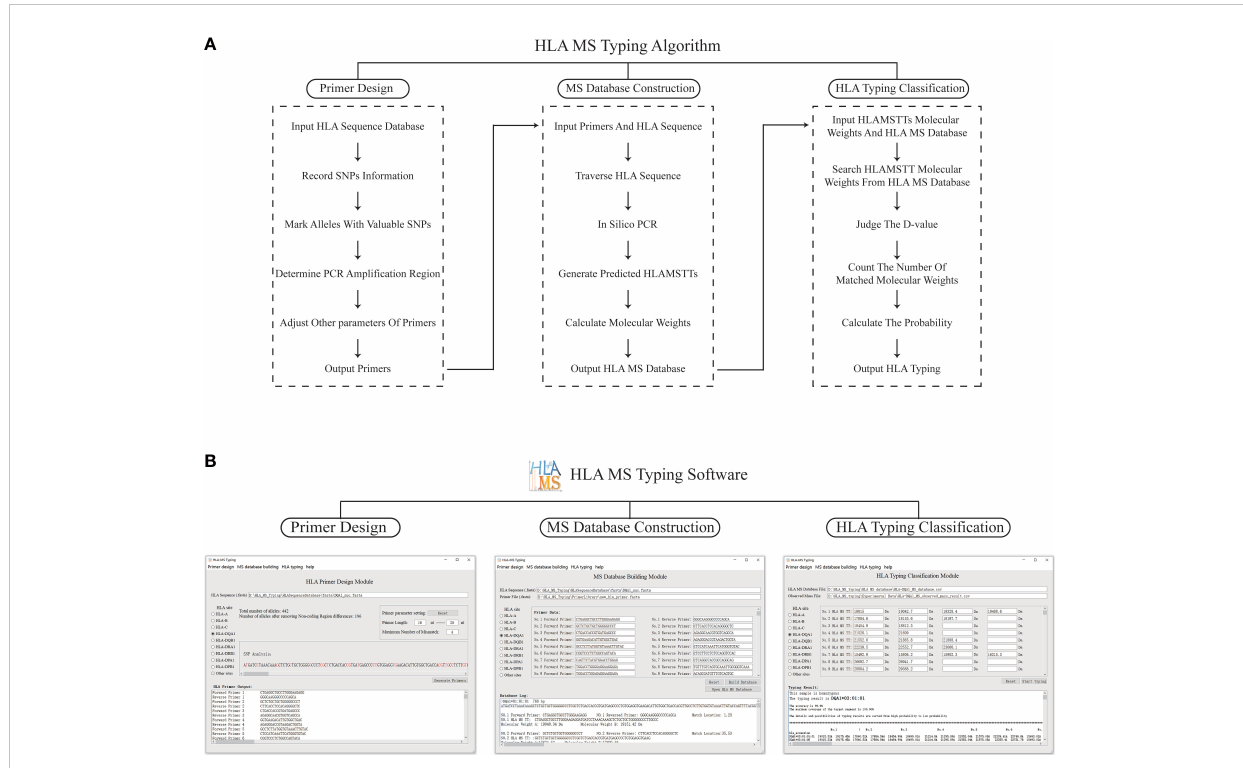
FIGURE 2 The schematic diagram and software interface of the HLA MS typing algorithm. (A) The HLA MS typing algorithm includes three modules: the primer design module, the database construction module, and the HLA typing classi fi cation module, which respectively complete the functions of PCR primer design, constructing the HLA MS database, and generating the HLA typing results following interrogation of the HLA MS database. (B) Three modules of the user interface: it mainly implements the import of HLA sequences, the export and import of PCR primers, the export and import of the HLA MS database, the output of typing results, typing scores, and detailed alignment